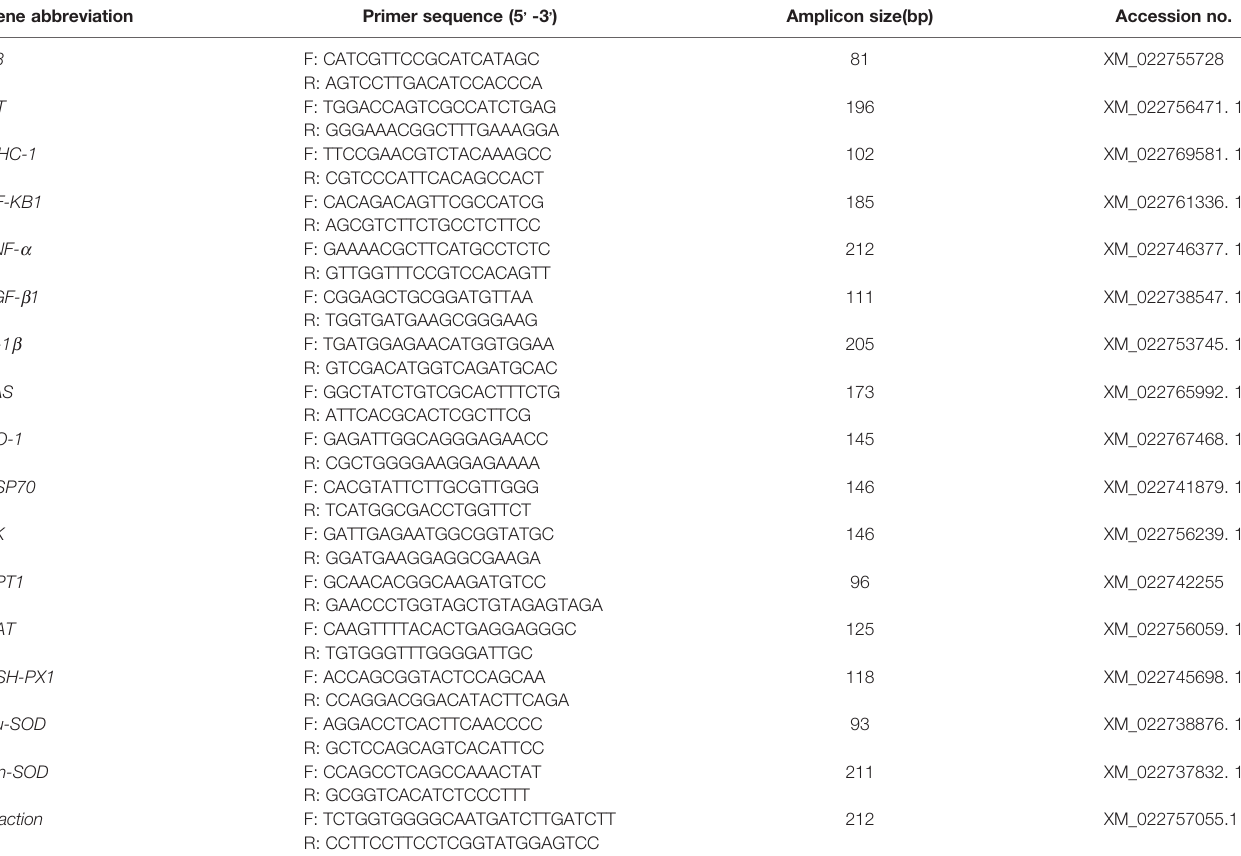
TABLE 1 | Set of forward and reverse primers used for the immune gene expression analysis in greater